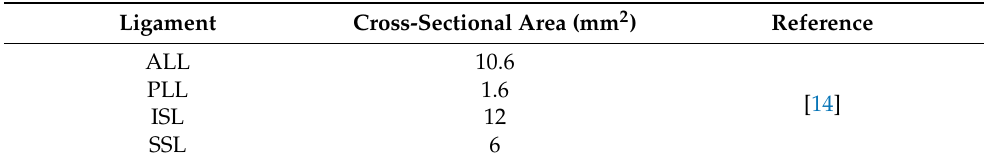
Table 2. Cross-sectional area of spinal